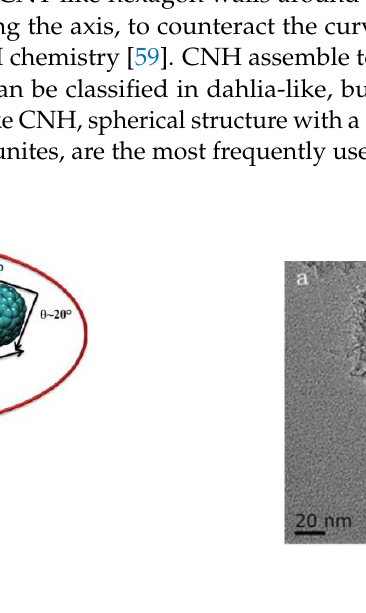
Figure 2. ( a ) Schematic representation of the morphological features of (A) dahlia like Carbon Nanohorns (CNH) and (B) single CNH, reproduced with permission from [63] , Elsevier (2019). ( b ) Representative TEM image of dahlia like CNH. Reproduced with permission from [64] , Elsevier (2015).